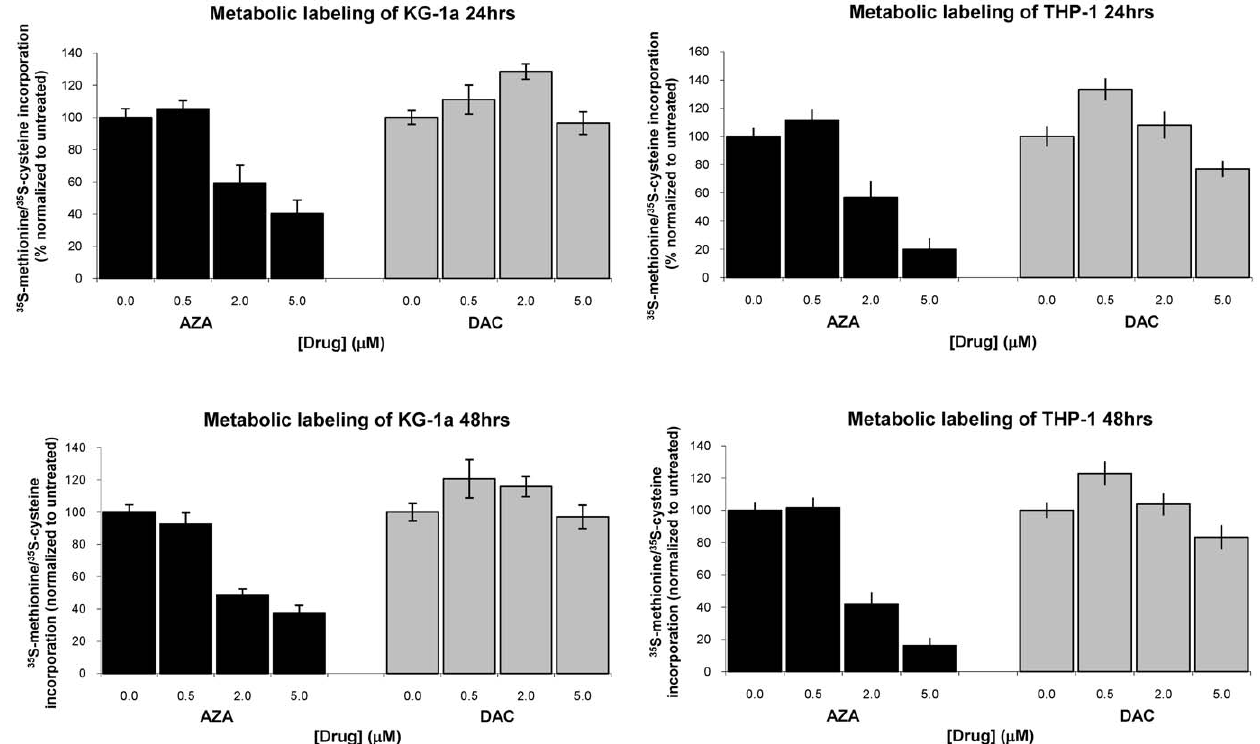
Figure 3. AZA inhibits protein synthesis in KG-1a and THP-1 cells. Cells were treated daily with AZA orDAC (0–5 m M)for 24 or48 hours prior to metabolic labeling with 35 S-methionine and 35 S-cysteine. Protein synthesis was quantified as described previously. AZA = azacitidine; DAC = decitabine.